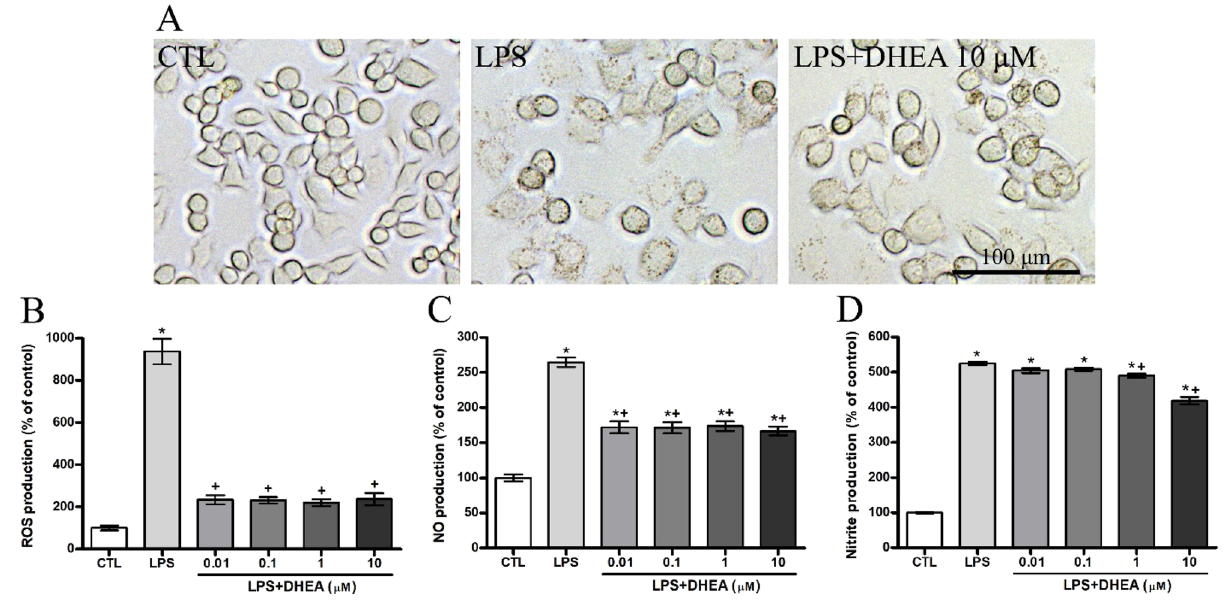
Figure 4. Inhibitory effect of DHEA on LPS-induced production of ROS, NO and nitrites in SIM-A9 microglial cells. ( A ) Representative images of microglial cells exposed to LPS and DHEA. Histogram showing the level of ( B ) ROS, ( C ) NO, ( D ) nitrites production in LPS-activated microglia cells treated with different concentrations of DHEA. *Significant differences between “CTL” and “LPS”, “LPS + DHEA” at similar observation points. + Significant differences between “LPS” and “LPS + DHEA” at similar observation points. Data are the mean ± SEM, n = 9 (number of analyzed samples), P < 0.05, (one-way ANOVA, post-test Tukey). Images were prepared with using GIMP 2.10.22 software (http://www.gimp.org/).